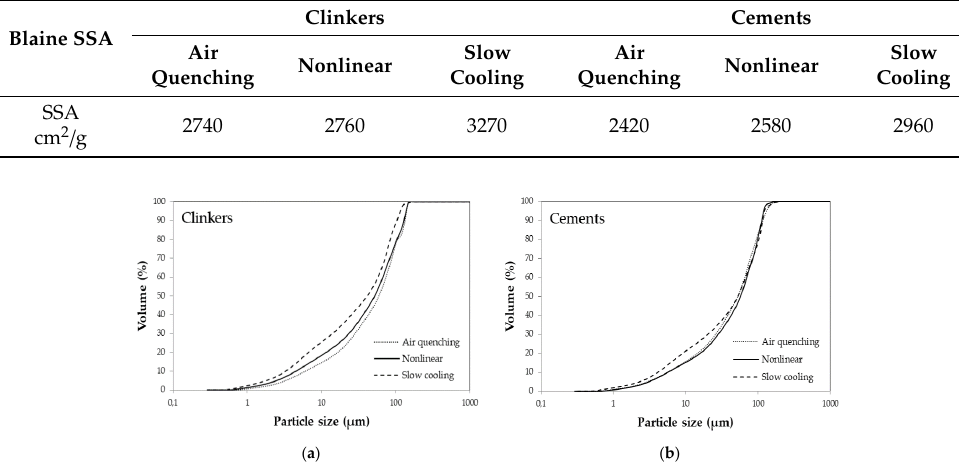
Table 2. Specific surface area (Blaine method, ToniPERM Standard Model 6578, ToniTechnic by Zwick, Ulm, Germany) of the ground clinkers and prepared cements.